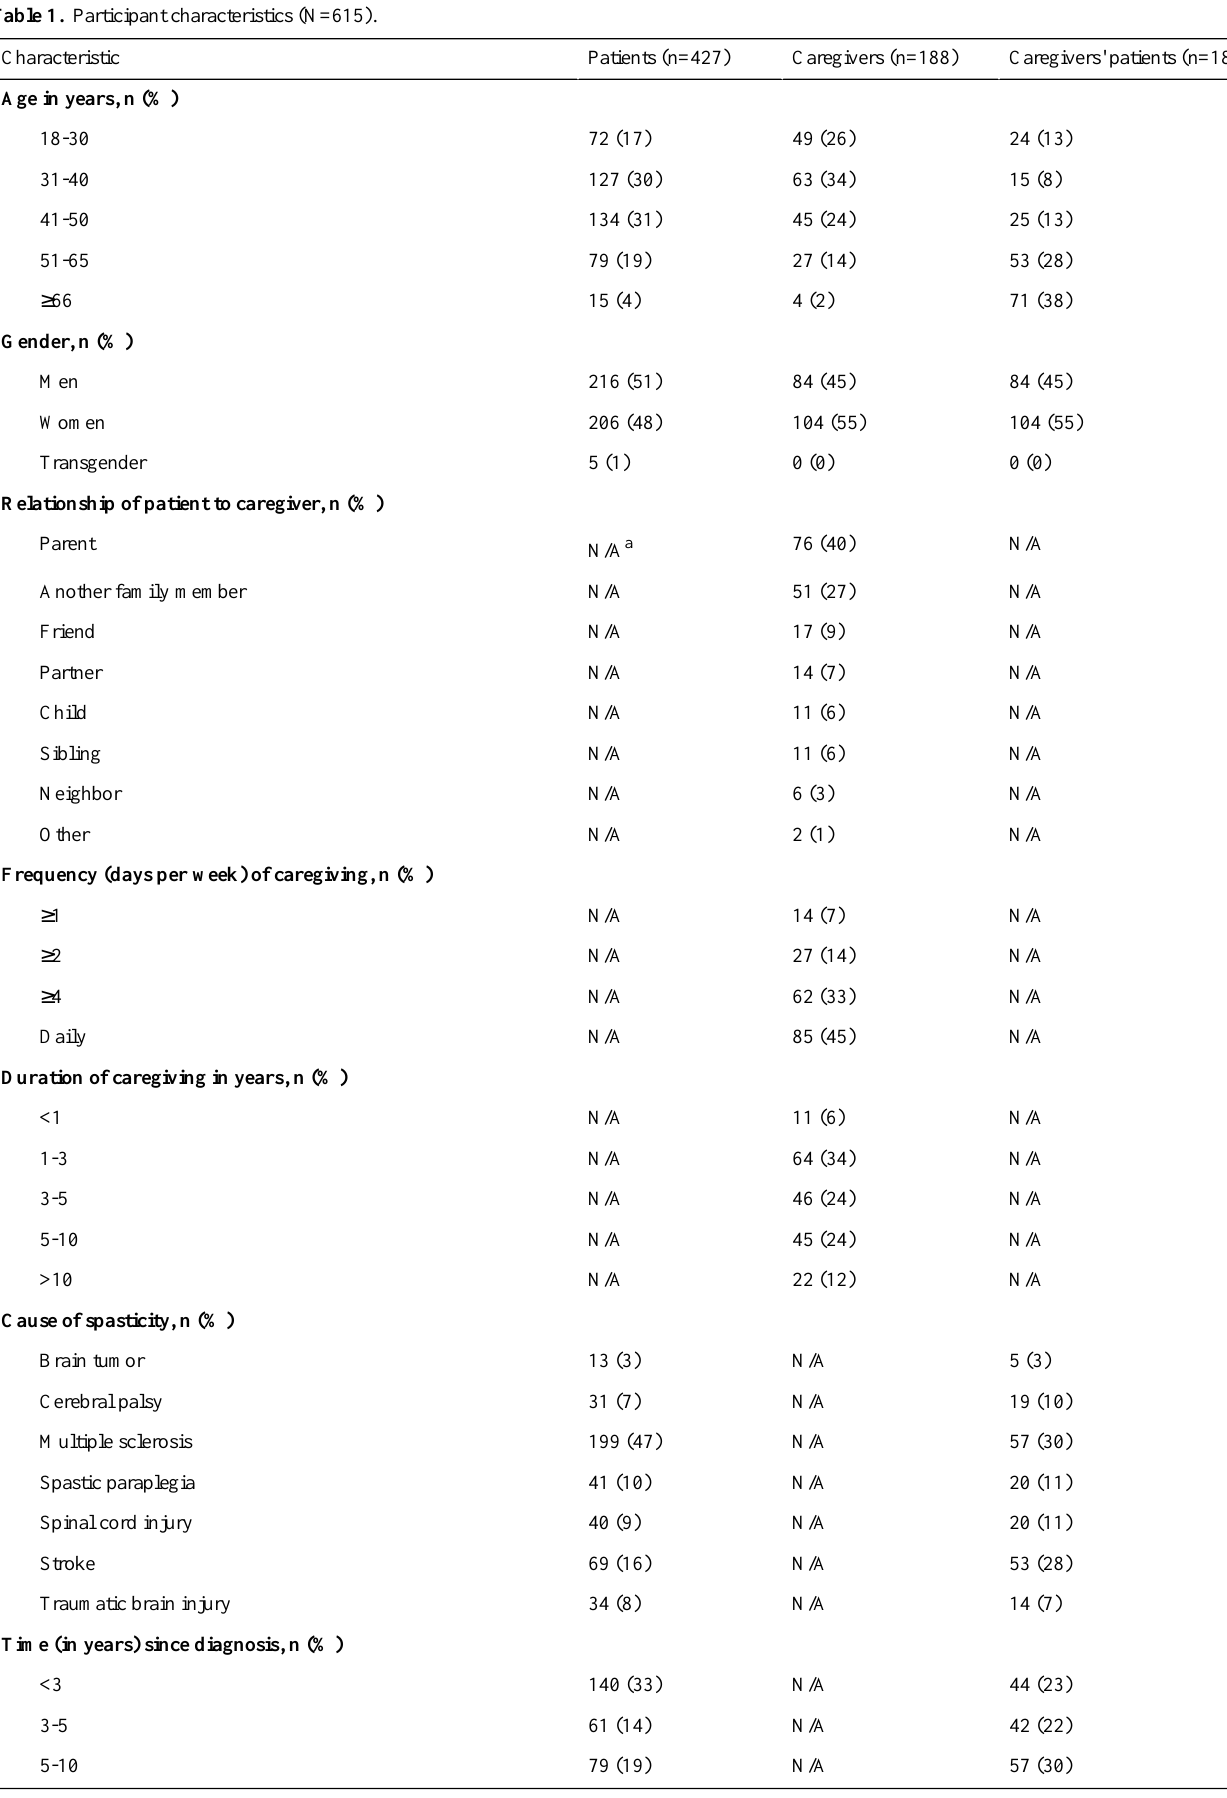
Table 1. Participant characteristics